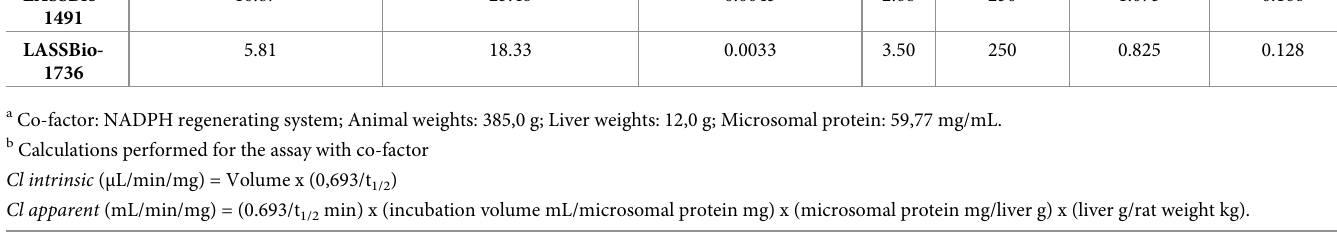
Table 4. Pharmacokinetic parameters determined from the in vitro microsomal stability studies of LASSBio-1491 and its isostere LASSBio-1736, using rat liver microsomes in the presence and absence of cofactor. Compounds Metabolism rate non co- factor a (%)